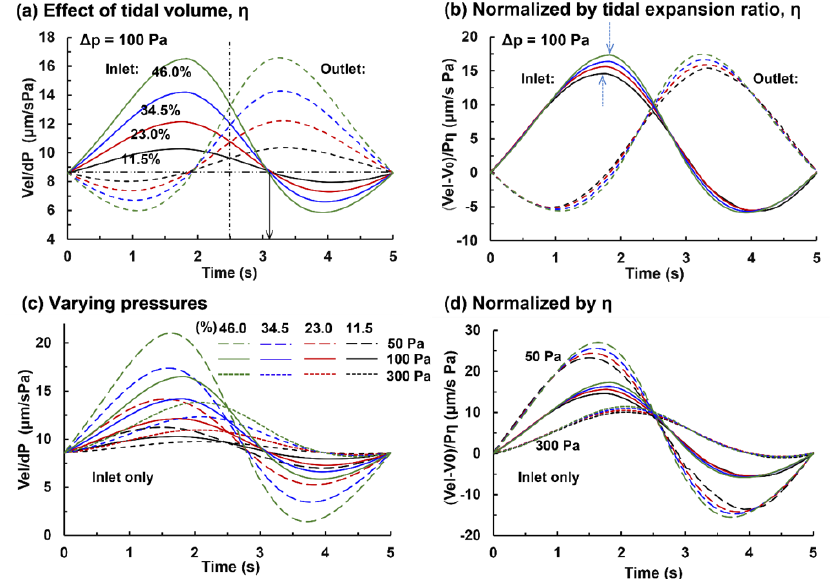
Figure 6. Effect of tidal volume (i.e., expansion ratio, η = Δ V/V): ( a ) instantaneous flow speeds normalized by pressure at different tidal volumes, and ( b ) instantaneous flow oscillations normalized by pressure and expansion ratio, ( c ) normalized capillary flow speed (by pressure) vs. time, and ( d ) normalized capillary flow speed (by pressure and tidal expansion ratio η ) vs. time.